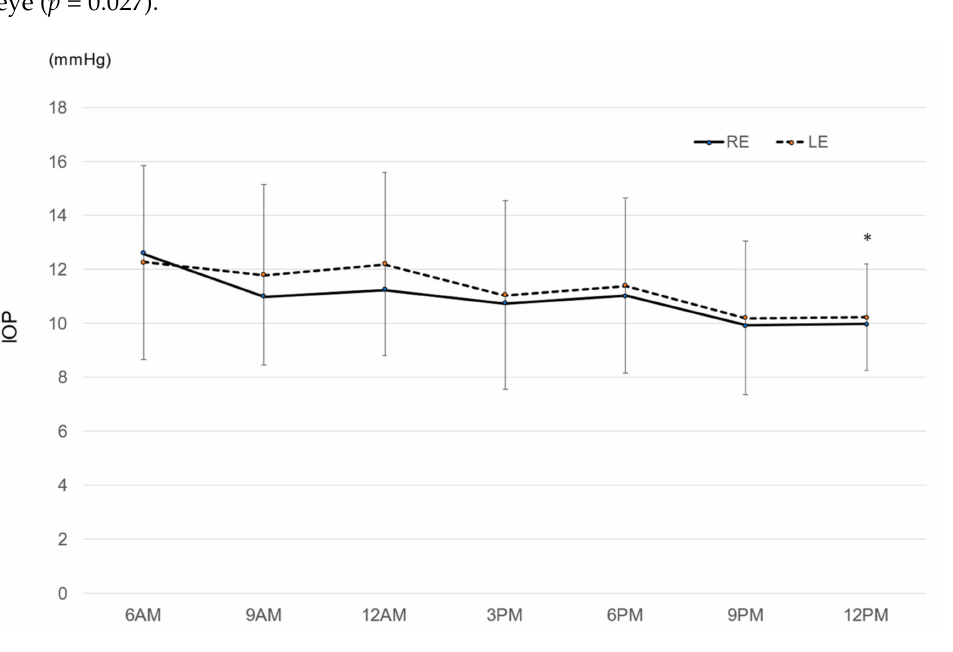
Figure 1. Mean diurnal intraocular pressure. * p = 0.027 6 AM vs. 12 PM, the Tukey–Kramer multiple comparison test. RE: right eye, LE: left eye, bar = standard